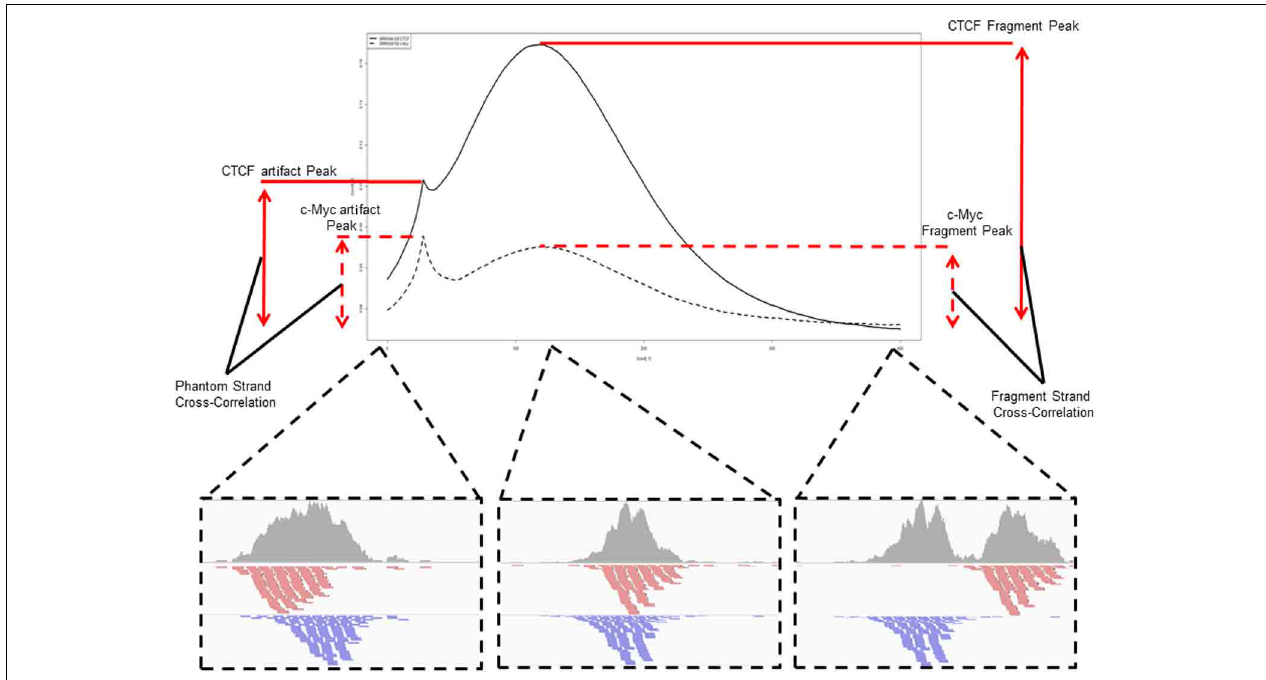
FIGURE 5 | An example and illustration of the assessment of cross-correlation following shifting of the reads on the Watson strand. The cross-correlation of the CTCF ChIP sample (SRR568129) shows the dominance of the fragment-length cross correlation peak over the read-length